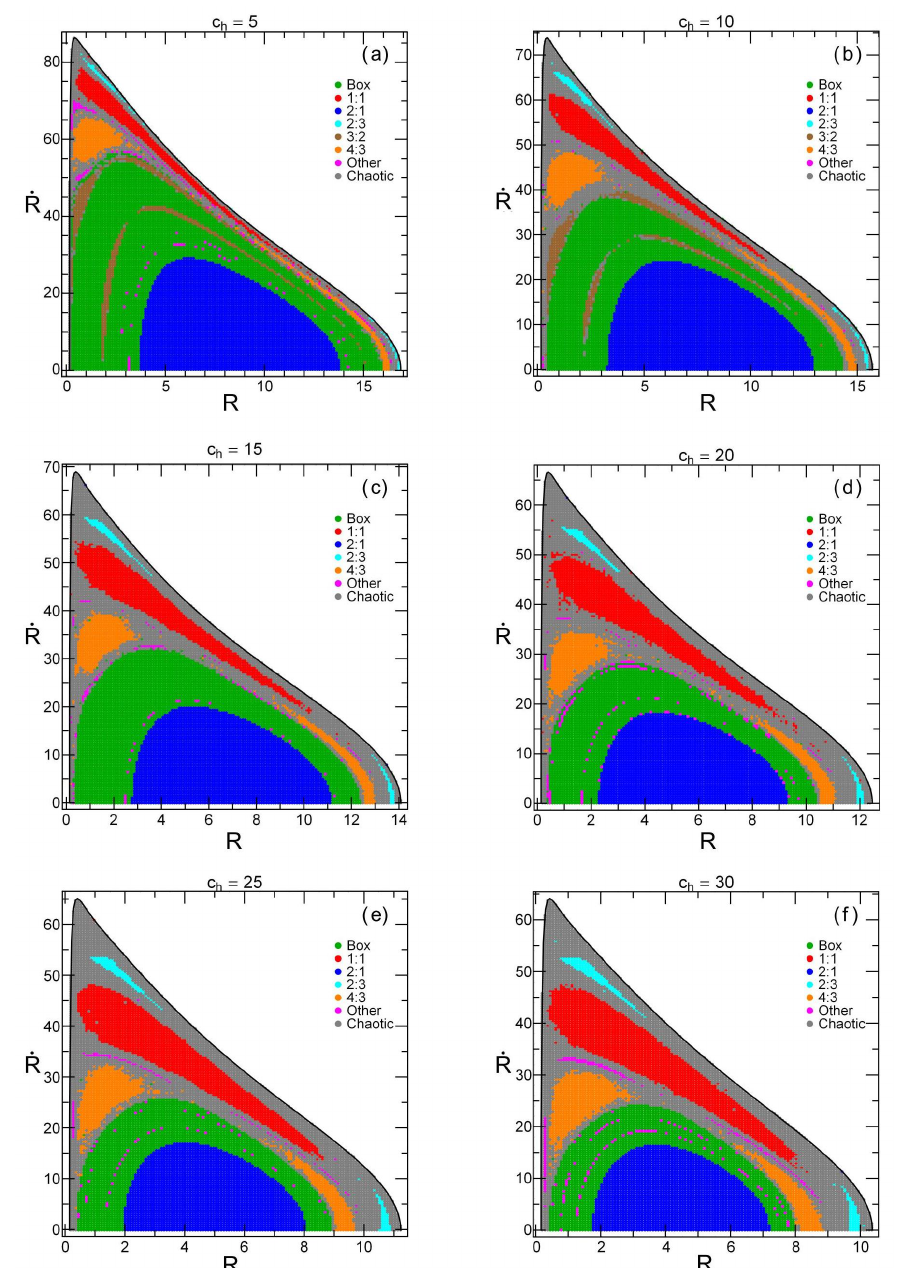
Fig. 5. Orbital structure of the phase plane ( R; ˙ R ) of our galaxy model for different values of the scale length of the dark halo c h